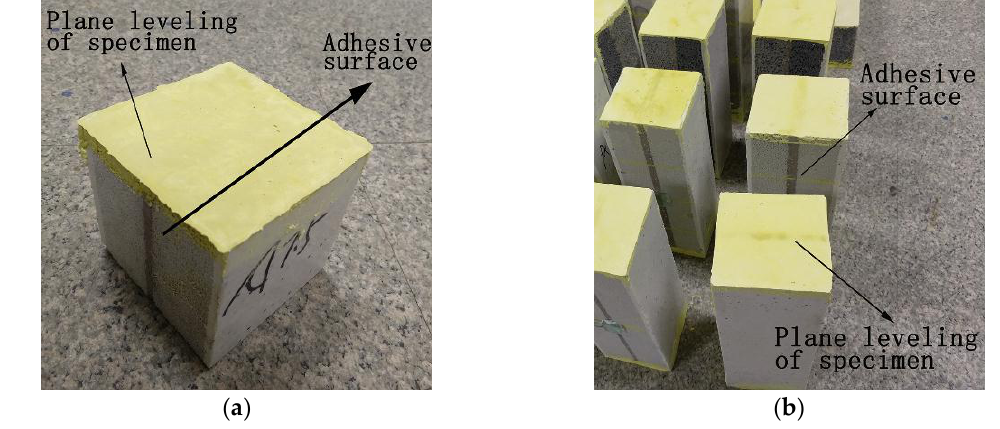
Figure 3. Specimen preparation for the compression test. ( a ) Cubic specimen; ( b ) Prism specimens.